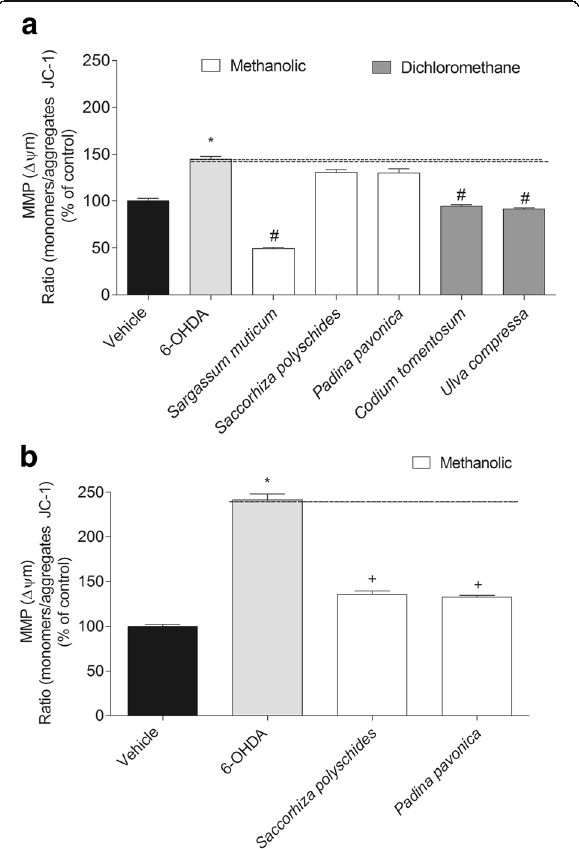
Fig. 5 6-OHDA (100 μ M) effects in the presence or absence of seaweeds extracts (1 mg/mL) in mitochondrial membrane potential of SH-SY5Y cells after 3 h ( a ) and 6 h ( b ) of incubation. The results were obtained by the ratio between the monomers/aggregates of JC-1. The values in each column represent the mean ± standard error of the mean (SEM) of 3 or 4 independent experiments. Symbols represent statistically significant differences ( p < 0.05, ANOVA, Dunett ’ s test) when compared to: * vehicle. # to 6-OHDA